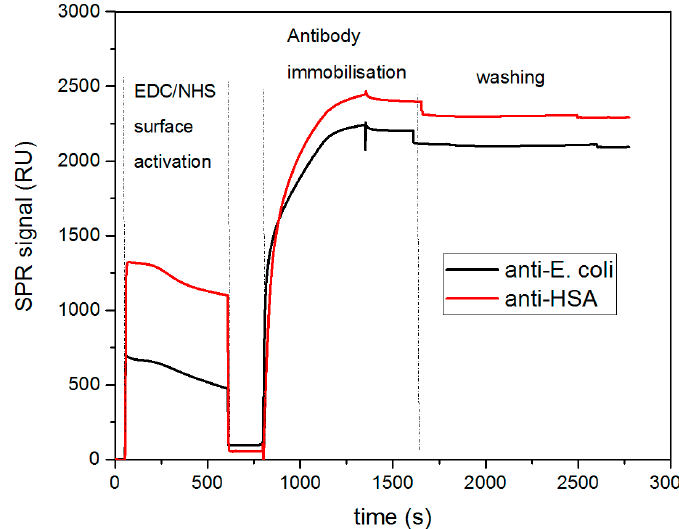
Figure2. Real-timemonitoringofanti-HumanSerumAlbuminandanti- E.coli immobilizationbysurface Figure 2. Real-time monitoring of anti-Human Serum Albumin and anti- E. coli immobilization by plasmon resonance. The gold surface was first activated with 1-ethyl-3-(3-(dimethylamino)-propyl) surface plasmon resonance. The gold surface was first activated with carbodiimide and N-hydroxy succinimide (EDC / NHS) chemistry and subsequently loaded with 1-ethyl-3-(3-(dimethylamino)-propyl) carbodiimide and N-hydroxy succinimide (EDC/NHS) corresponding antibodies onto two separate channels. SPR curves were subtracted by a reference chemistry and subsequently loaded with corresponding antibodies onto two separate channels. SPR channel signal where no antibody was immobilized. Deactivation with ethanolamine and blocking curves were subtracted by a reference channel signal where no antibody was immobilized. operations with Bovine Serum Albumin are not Deactivation with ethanolamine and blocking operations with Bovine Serum Albumin are not shown.